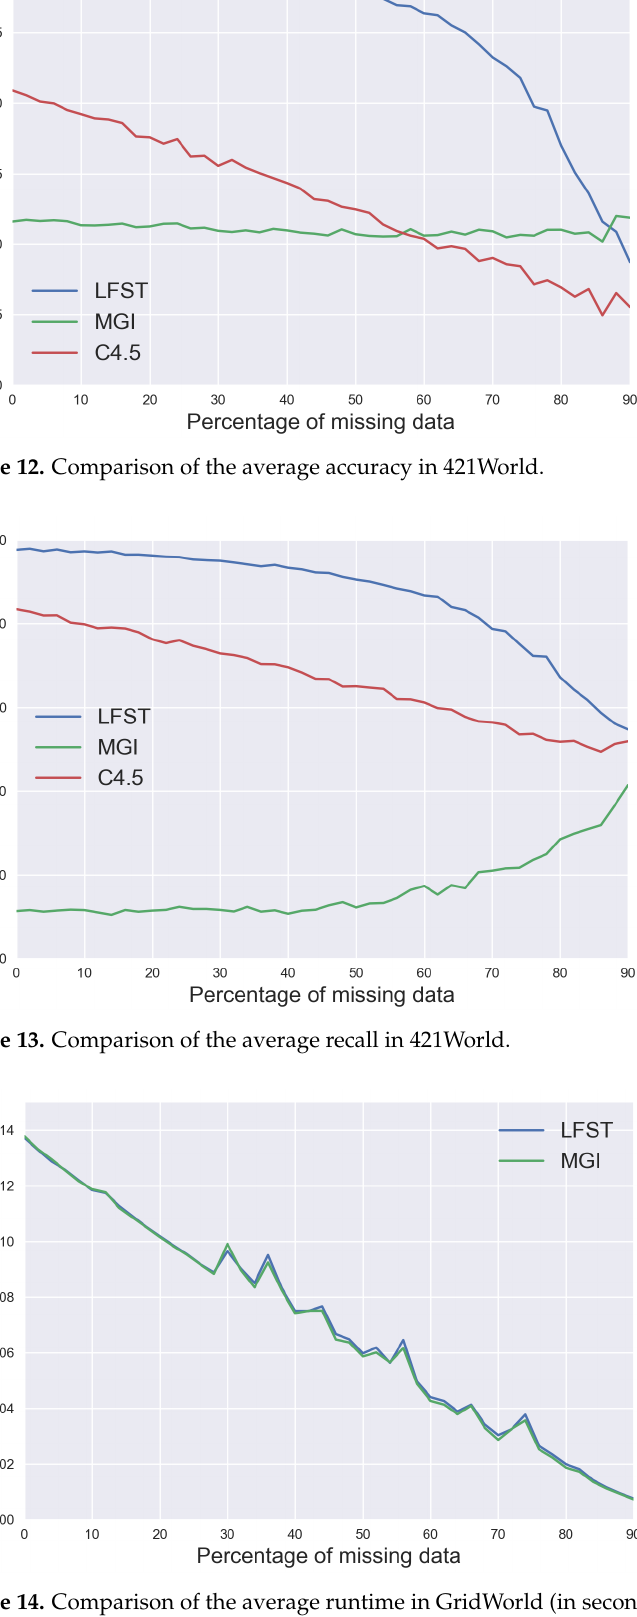
Figure 14. Comparison of the average runtime in GridWorld (in